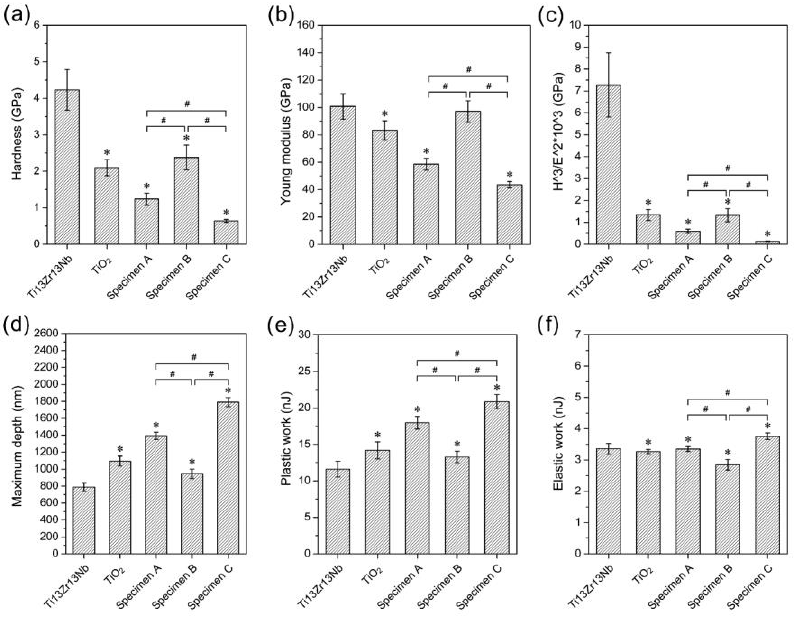
Figure 10. Nanomechanical properties: ( a ) hardness, ( b ) Young modulus, and ( c ) H 3 /E 2 ; nanoindentation properties: ( d ) maximum depth, ( e ) plastic work, and ( f ) elastic work for Ti13Zr13Nb substrate, substrate with the TiO 2 nanotube layer, Specimen A, Specimen B, and Specimen C.